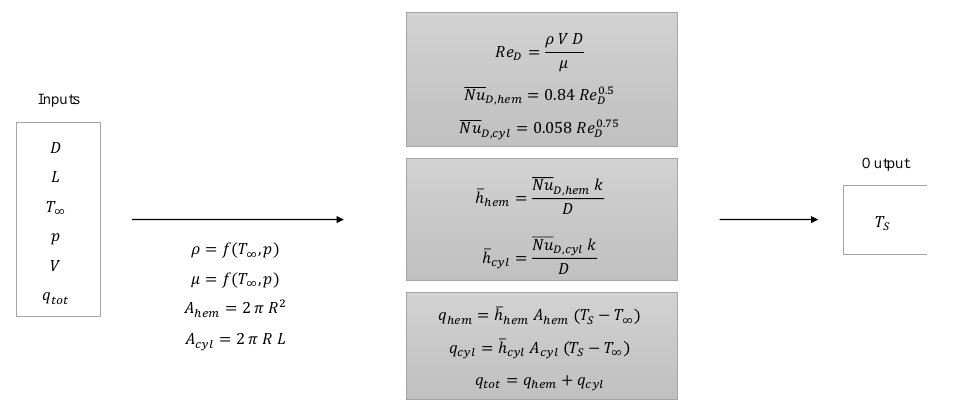
Figure 6. Inputs, computation formulas and output of the analytical model.